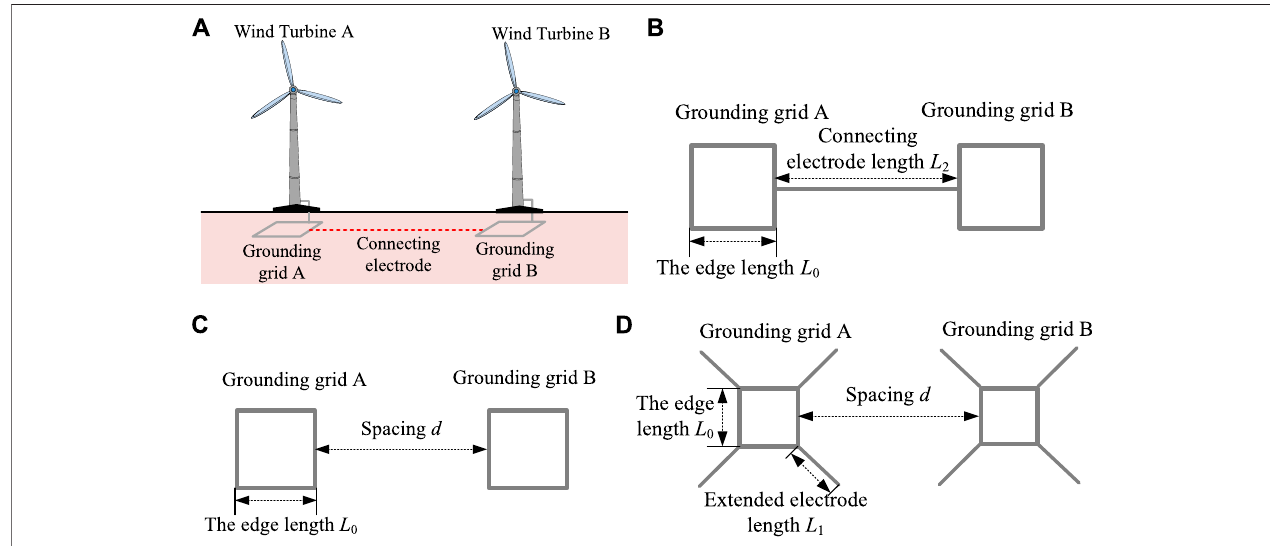
FIGURE1 | Schematic diagram ofthenearbywind turbine grounding grid. (A) Nearbywind turbinegrounding grid connection. (B) Grounding grid connection. (C) Box grounding grid. (D) Box extension grounding grid.